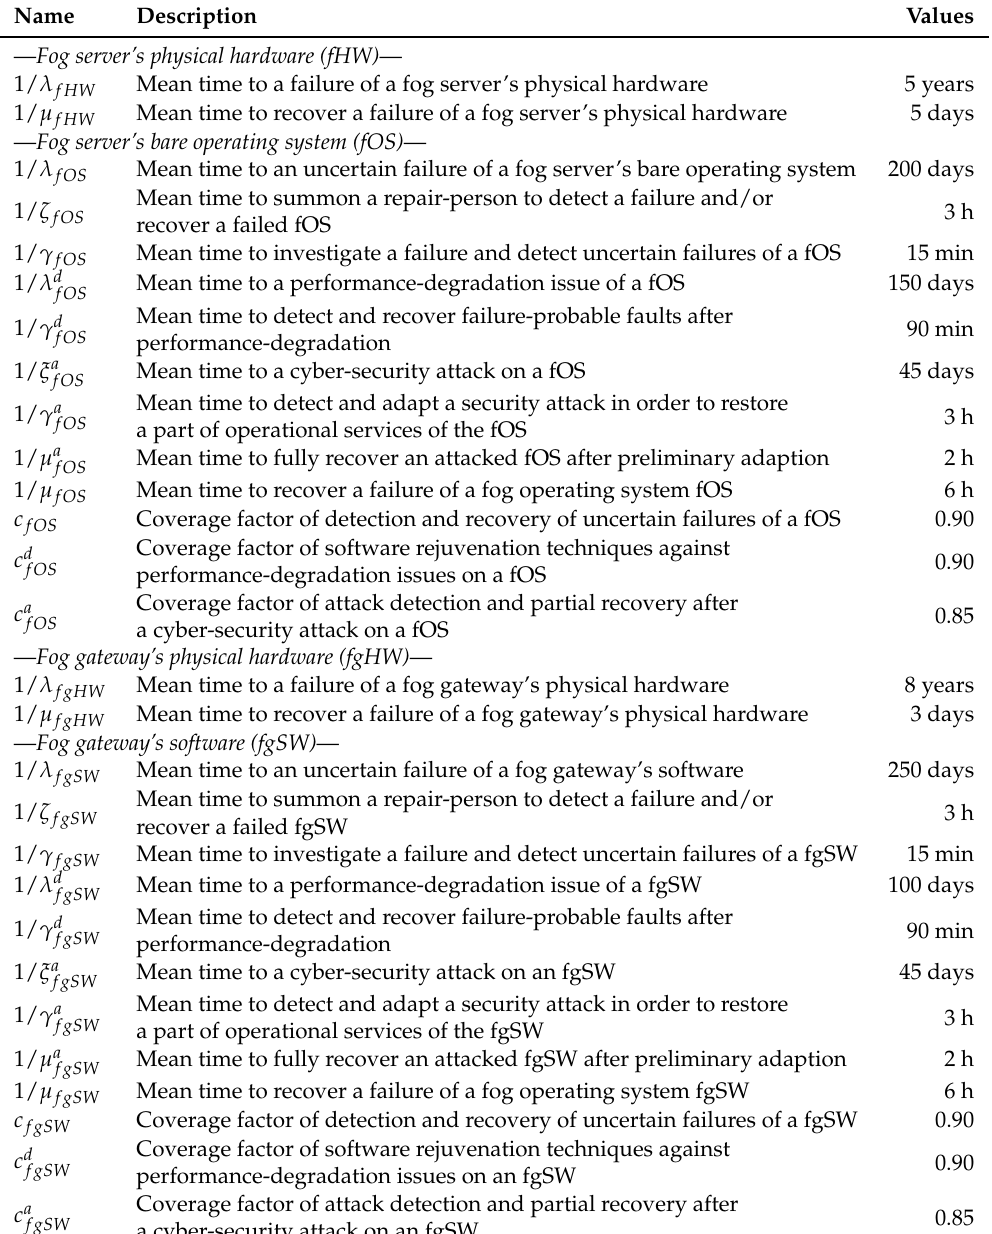
Table 2. Default input parameters for models of the fog member